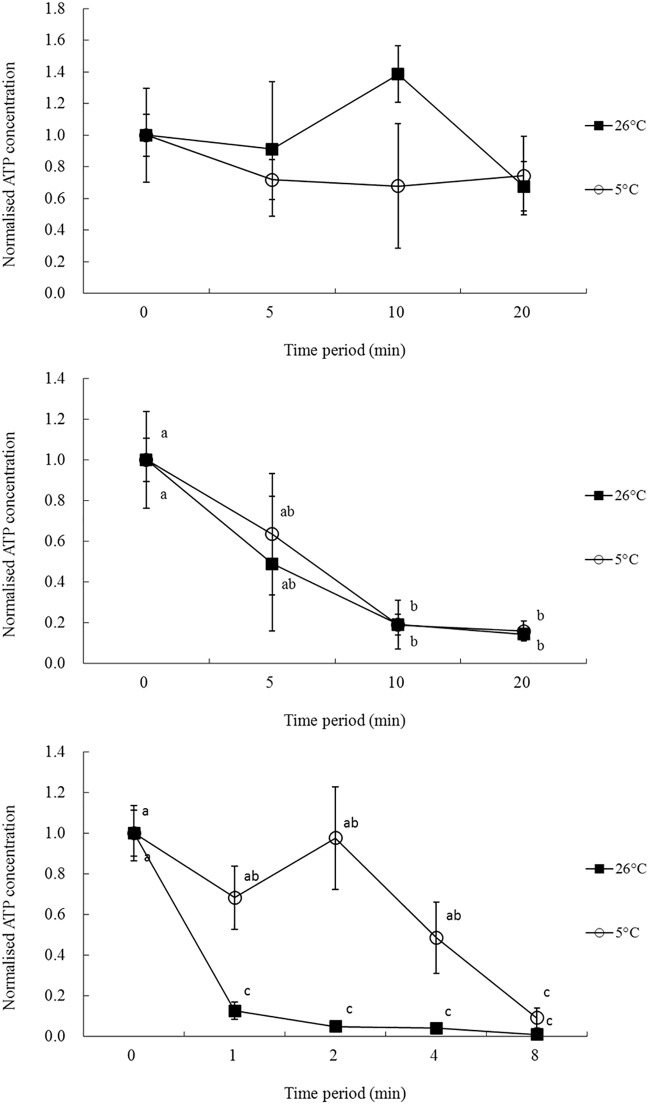
The effects of PG-based ES1 (a), ES2 (b) and VS2 (c) on Junceella juncea oocytes at 5 and 26°C for different time periods.Oocyte ATP levels were normalized to that of the control. Error bars represent standard errors. Different letters represent significant differences between temperature and exposure time period for oocytes treated with the same solutions (P < 0.05).